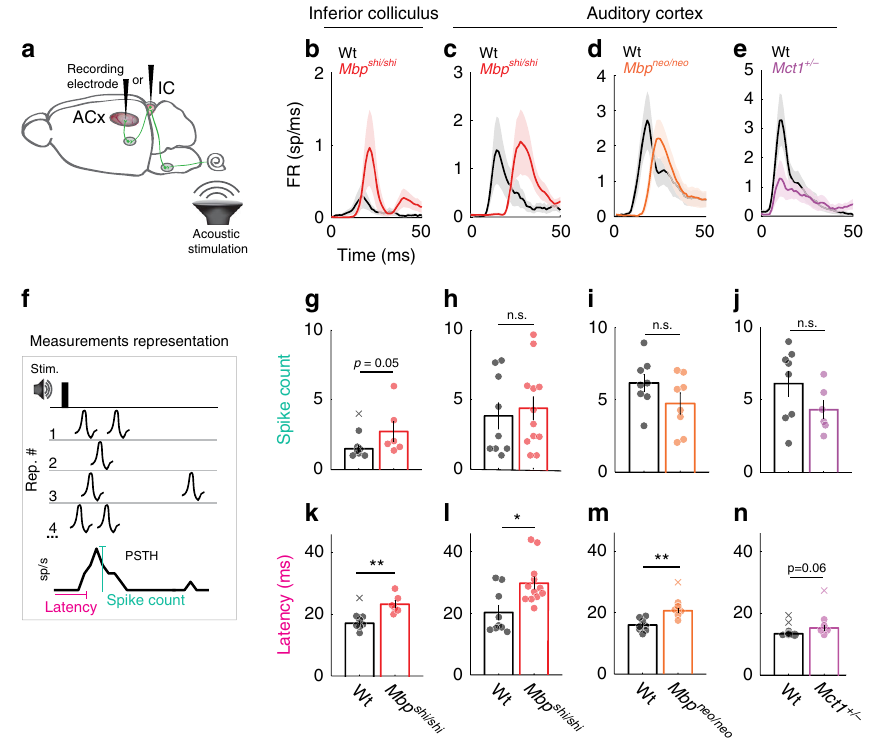
Fig. 5 Responses to single sound stimuli in IC and ACx of dysmyelinated models are abnormal only in latency. a Recording locations (inferior colliculus or cortex). b Peristimulus time histogram (PSTH) of responses to a click sound recorded in the IC for Wt (black, n = 6) and Mbp shi/shi (red, n = 7)